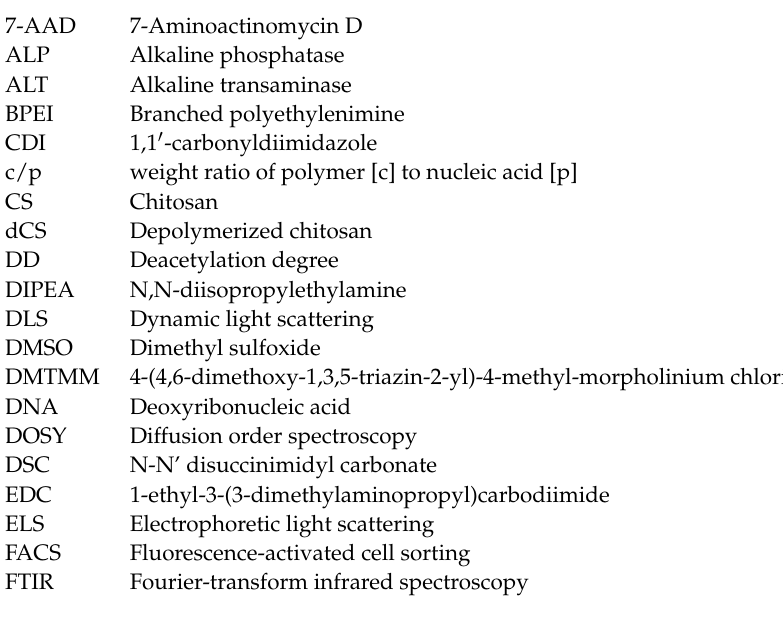
Figure S1: Detailed representation of PEI conjugation sites to dCS-Suc, Scheme S2: Strategies for the dual functionalization of dCS with PEI and PEG polymers, Table S2: Selection of the optimal synthetic sequence for the functionalization of amino and hydroxyl groups of dCS, NMR analyses and calculations for dCS and derivatives, Table S3: DNA exclusion assay to evaluate accessibility of DNA complexed with polymeric conjugates, Table S4: Scale up and reproducibility of dCS-Suc- LPEI synthesis, Figure S2: Quantitative analysis of in vitro GFP expression of the lead candidate